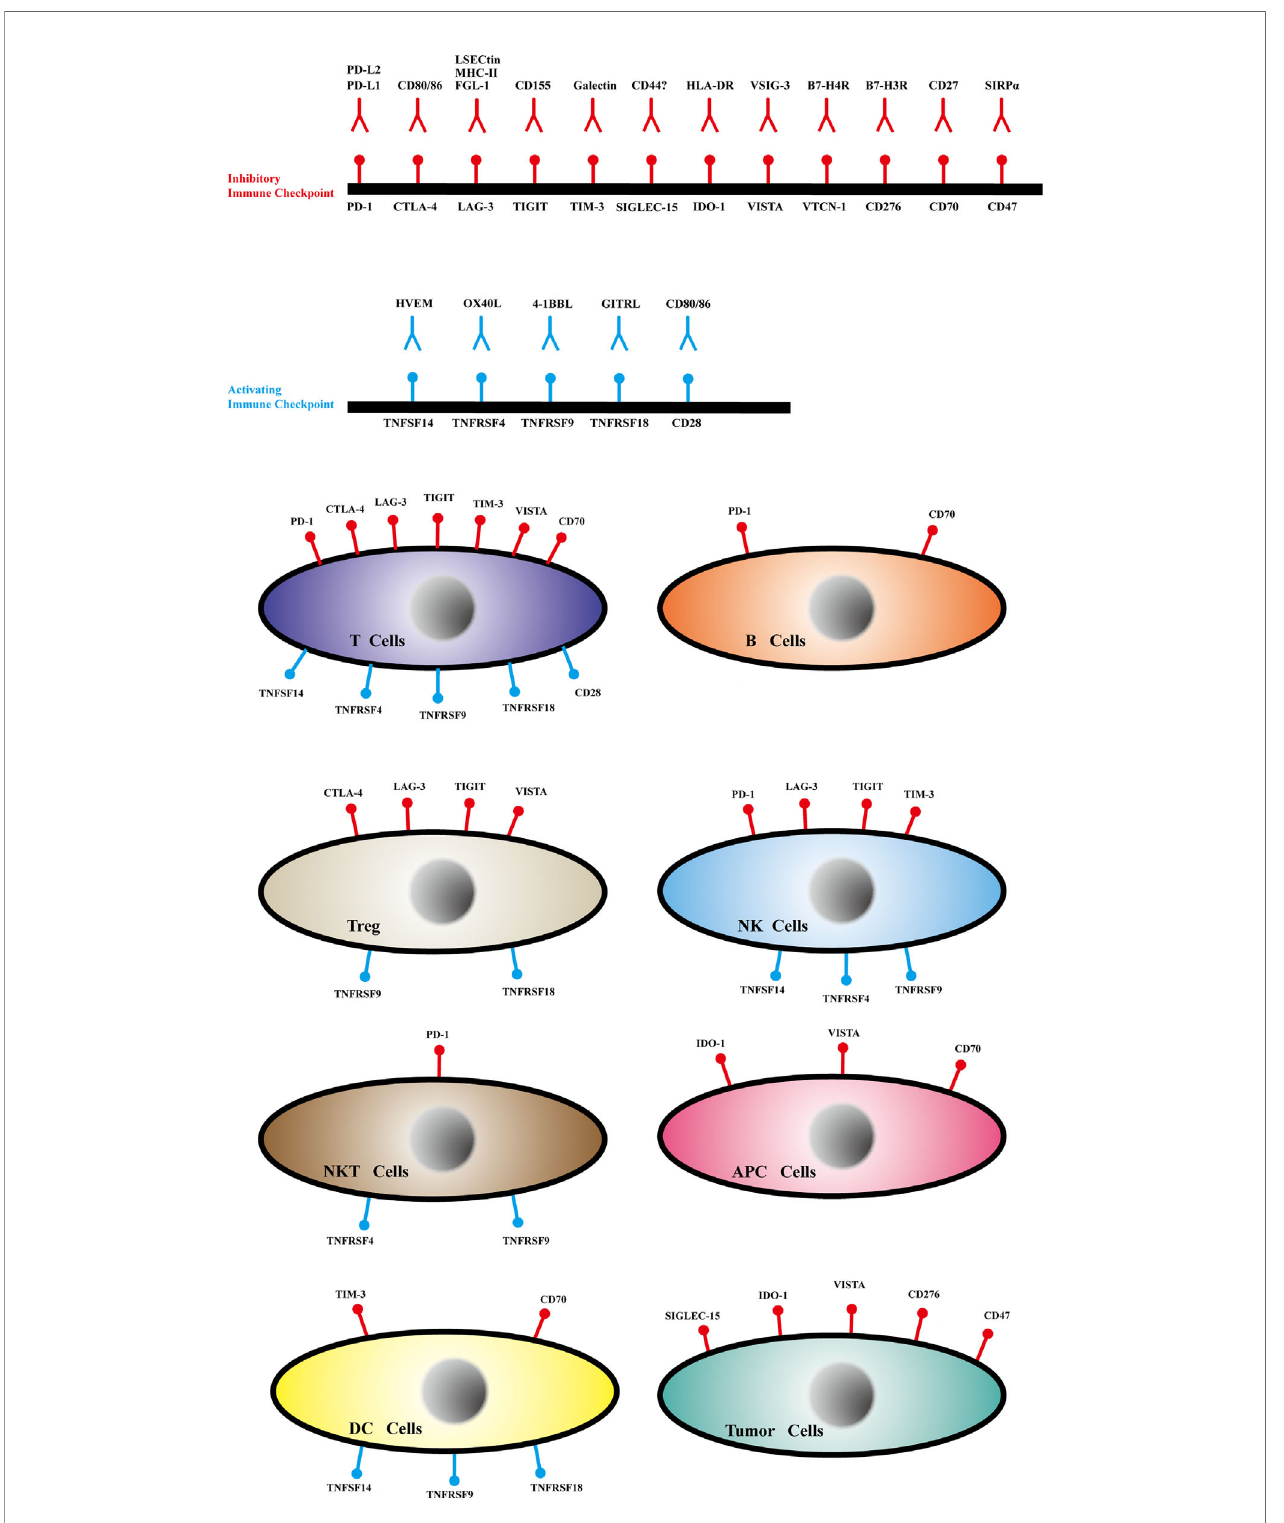
FIGURE 2 | The ligands, receptors and expression of immune